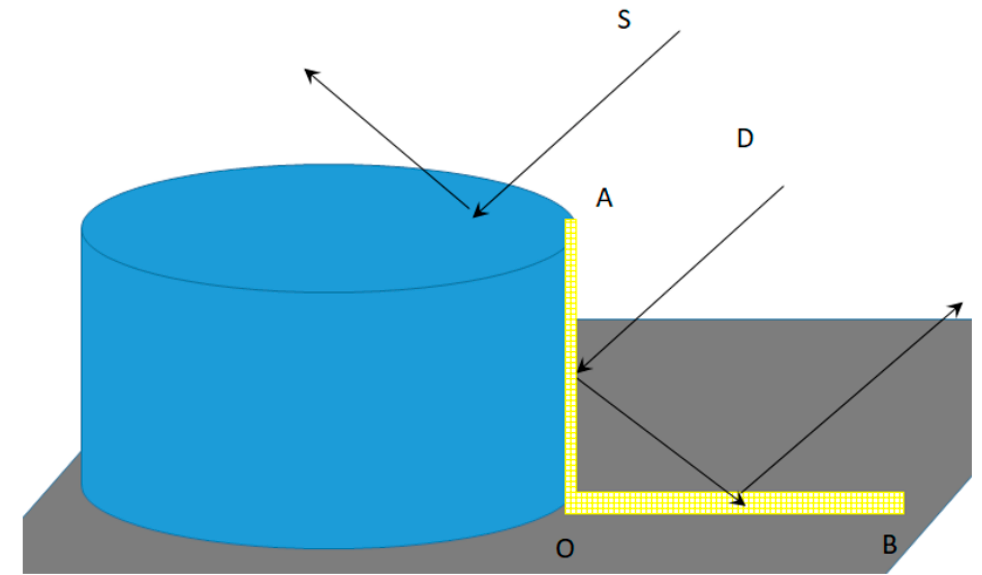
Figure 3. Interaction of radio waves with the tank surface: S — single scattering, D — double bounce scattering. AOB — dihedral corner reflector.